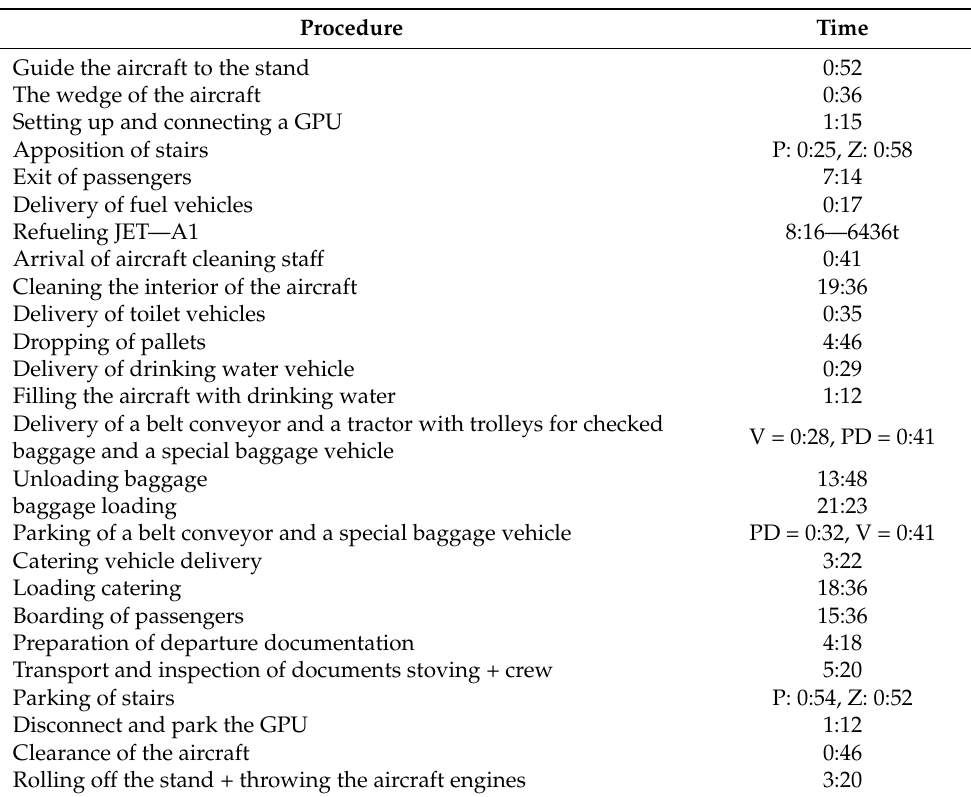
Table 4. Measurement of procedures after changes were